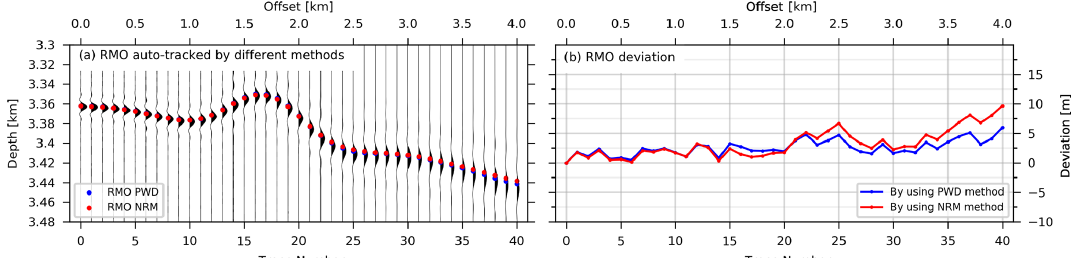
Figure 3. (a) Comparison of residual depth error picks between the NRM and PWD method. (b) Depth difference between the depth errors of the NRM and PWD method.